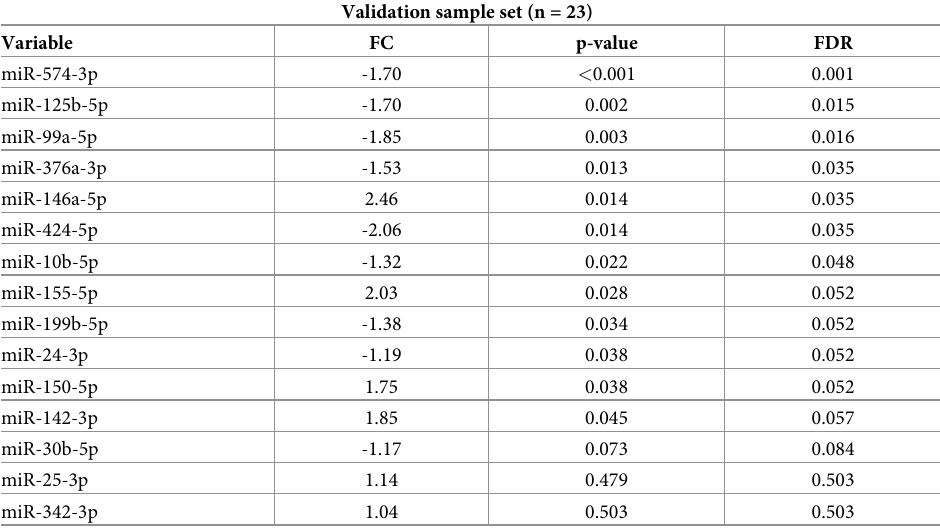
Table 2. The median fold change (FC) in miRNAs expression observed in the validation analysis for LS specimens relative to non-LS specimens.